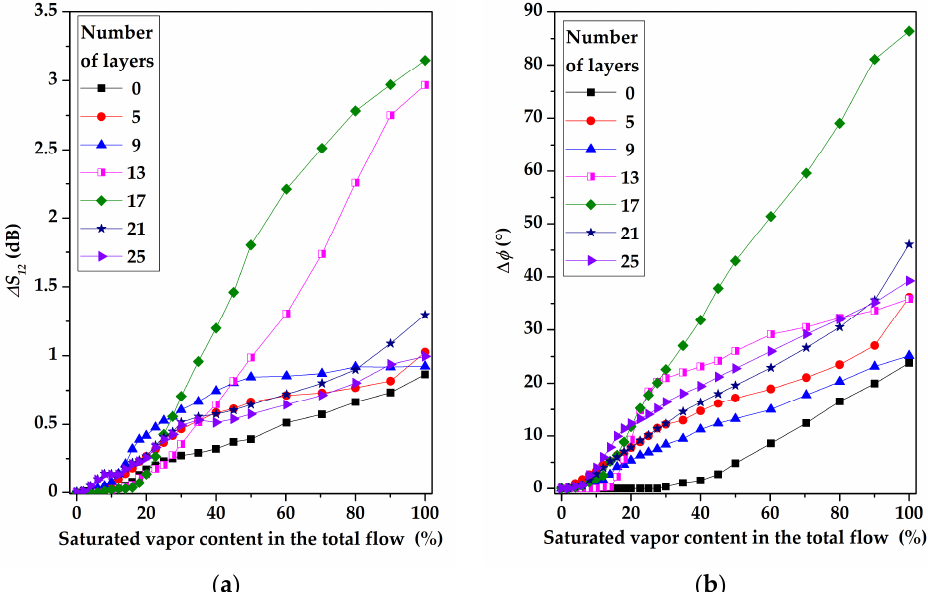
Figure 20. The change in ( a ) the S 12 parameter and ( b ) phase for device #2 coated with LB SA-sensitive film versus chloroform concentration was measured for different numbers of SA monolayers in LB SA-sensitive film.